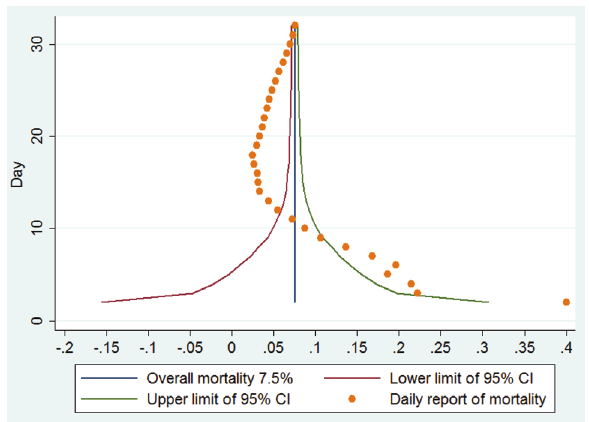
Figure 1. Funnel plot of case fatality